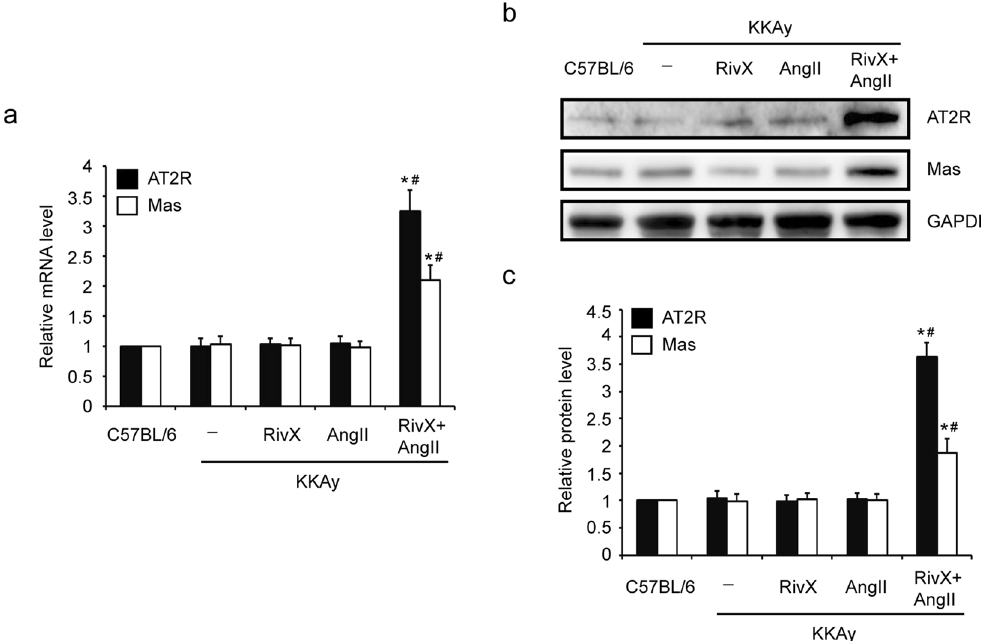
Figure 4. Combination of rivaroxaban and AngII up-regulated the expression levels of AT2R and Mas. Mice were administered orally with rivaroxaban (RivX, 5 mg/kg body weight/day) or infused with AngII (1,500 ng/ kg/min) or co-treated with RivX and AngII for 2 weeks. Under isoflurane anesthesis, the aortae were harvested. ( a ) The relative mRNA expression levels of AT2R and Mas were detected. The bars show the mean ± SEM (n = 5). * P < 0.05 compared with the group treated with RivX alone, and # P < 0.05 compared with the group treated with AngII alone; ( b ) The protein expression levels of AT2R, Mas, and GAPDH were detected using Western blot analysis. Cropped Images for representative blots were shown. Images for the full-length blots can be found in the supplementary information; ( c ) The relative protein expression level was expressed as fold changes over that of the C57BL/6 control group. The bars show the mean ± SEM (n = 4). * P < 0.05 compared with the group treated with RivX alone, and # P < 0.05 compared with the group treated with AngII